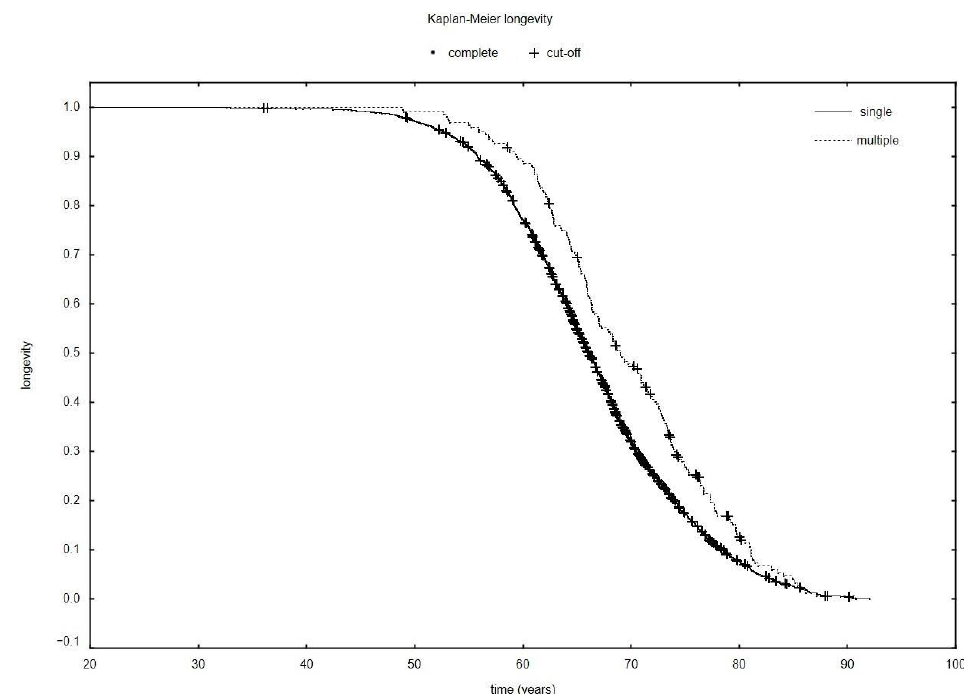
Figure 1. The Kaplan–Meier longevity in patients with multiple and single neoplasms.